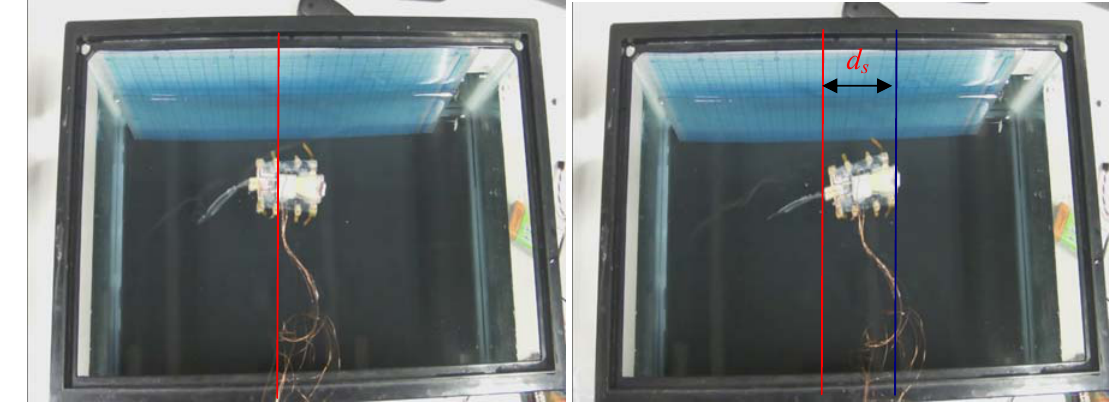
( c ) Right Bending ( d ) Final Position (blue